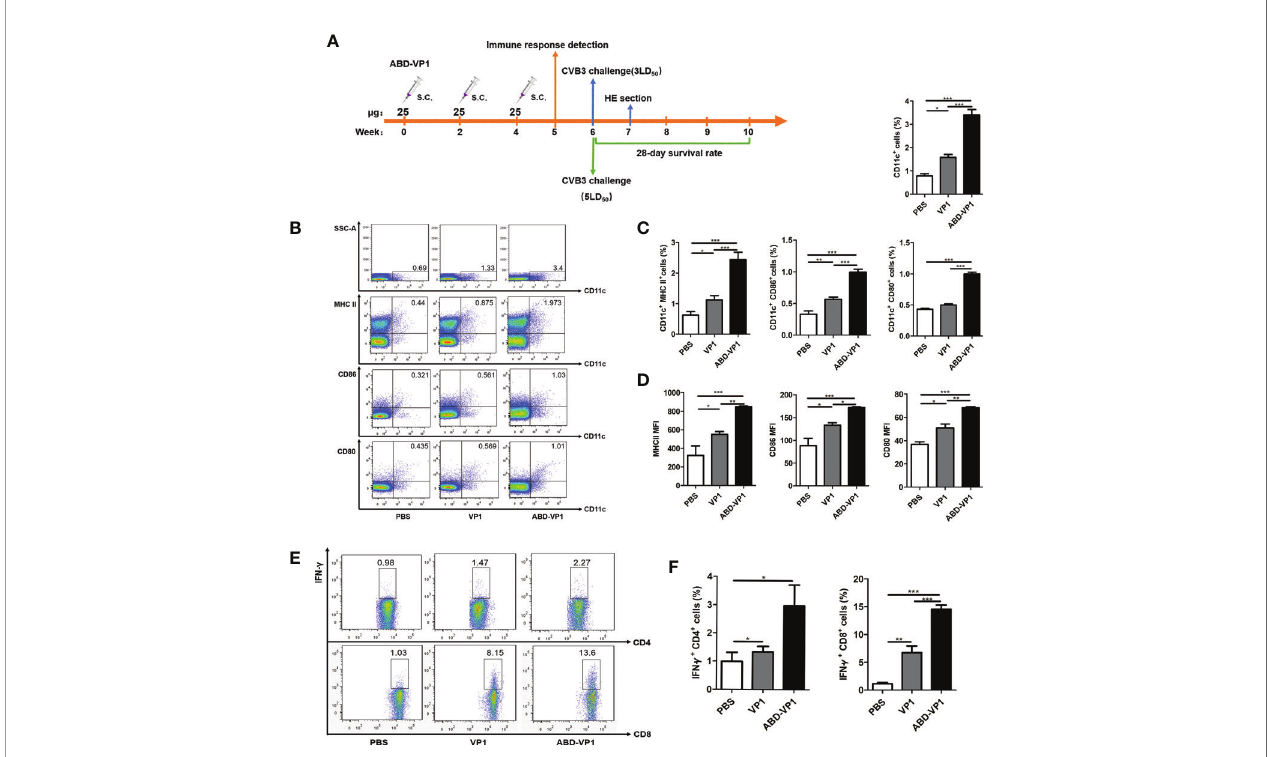
FIGURE 3 | ABD-VP1-induced local immune responses in the dLNs. (A) Schematic diagram of the immunization procedure. (B) FACS analysis of DC recruitment and maturation in the dLNs of immunized mice. (C) Statistical analysis of (B) . (D) Mean fl uorescence intensity (MFI) of MHC II, CD86 or CD80 molecule on CD11c + DC in the dLNs. (E) FACS analysis of IFN - g + CD8 + and IFN - g + CD4 + cells in the dLNs (unstimulated background has been subtracted). (F) Statistical analysis of (E) . Each group contained 8 mice. *P < 0.05; **P < 0.01; ***P < 0.001.